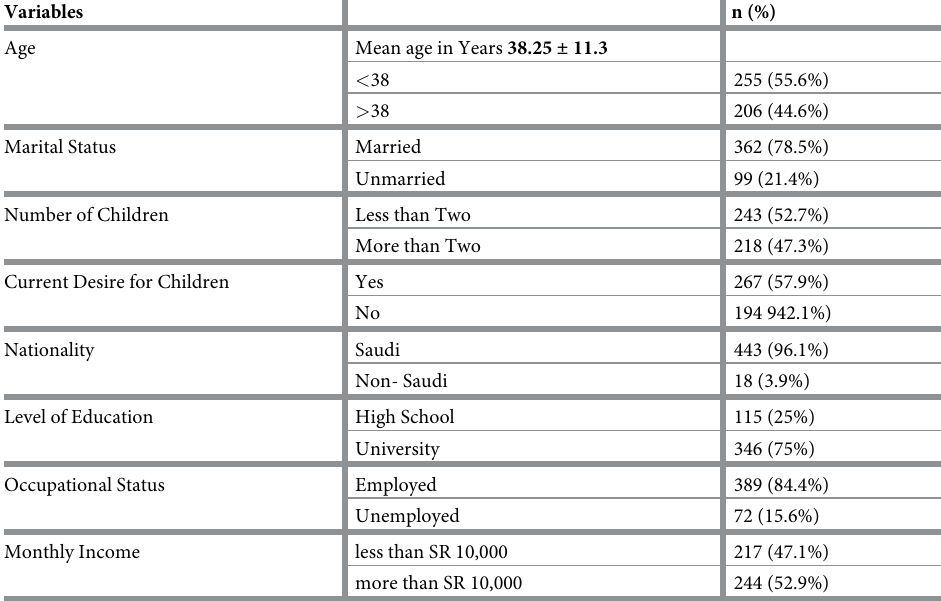
Table 1. Socio-demographic characteristics of the study population (N =